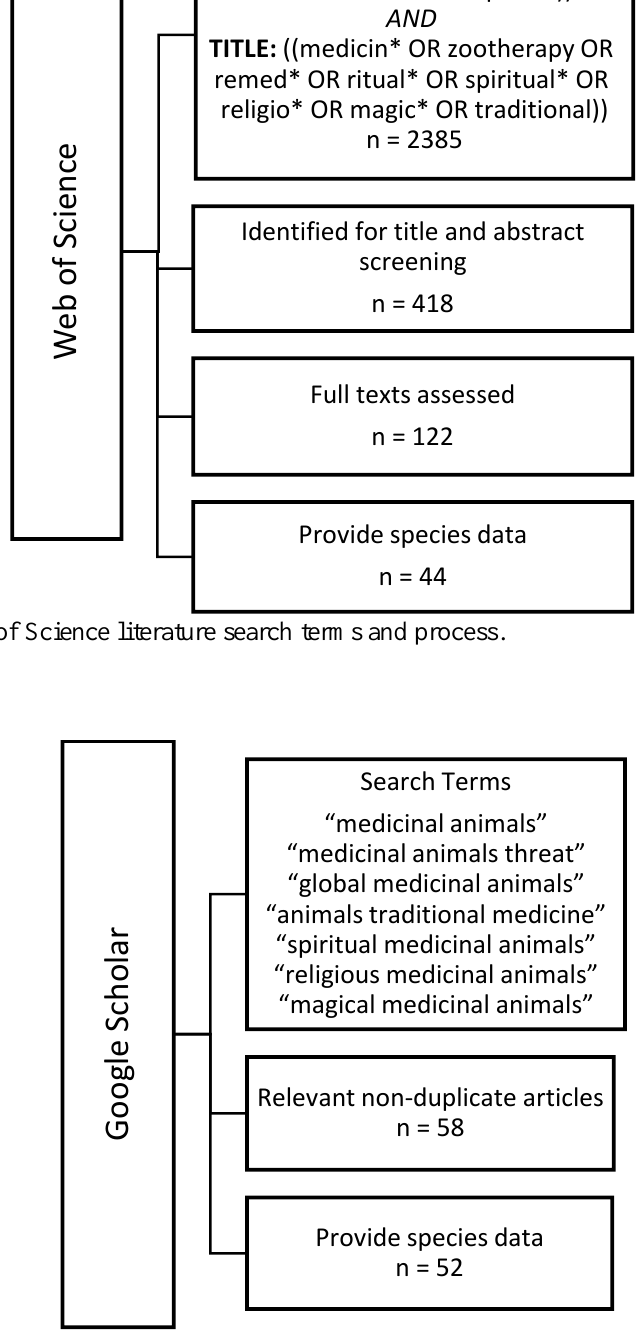
Figure A1.2: Google Scholar literature search terms and